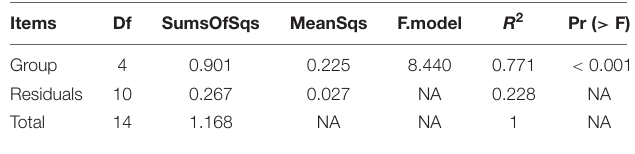
TABLE 5 | PerMANOVA of rumen bacterial samples based on Bray–Curtis